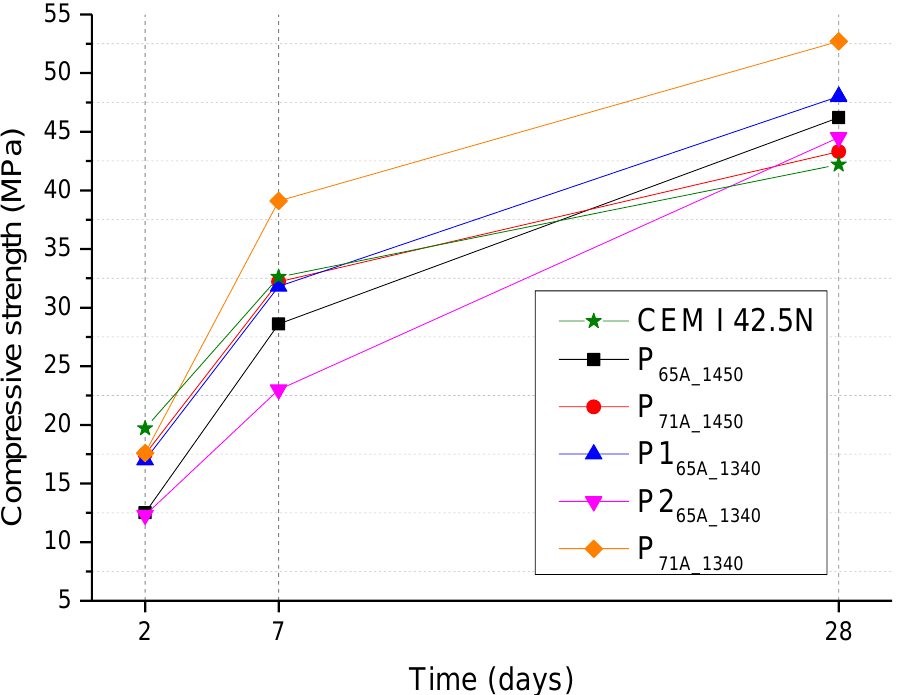
Figure 8. Compressive strength results for 2, 7 and 28 days of all cements.